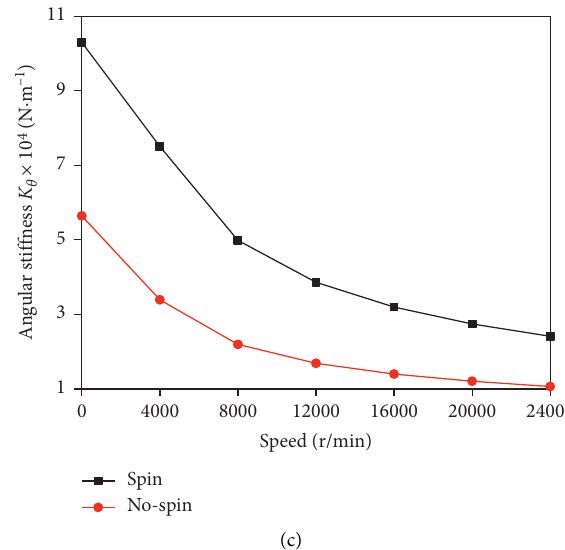
Figure 20: Influences of the speed and spin on the composite stiffness. (a) Radial stiffness. (b) Axial stiffness. (c) Angular stiffness.